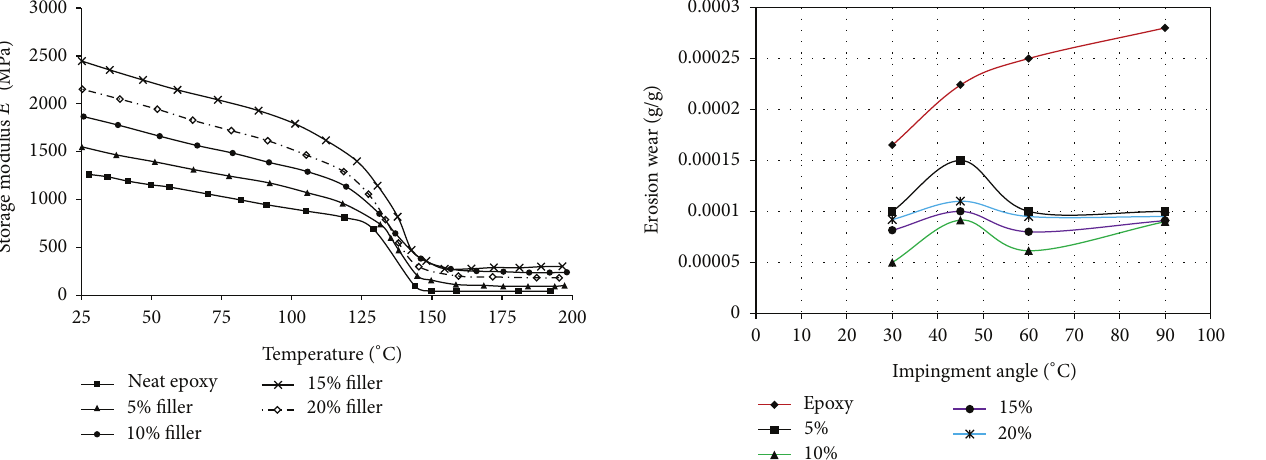
Figure 8: Effect of impingement angle on the erosion wear rate of the composites at impact velocity 48 m/s.